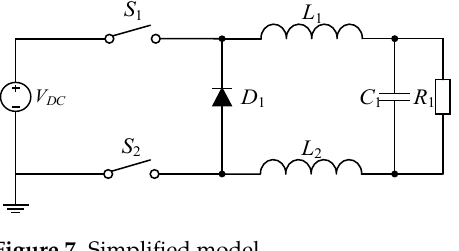
Figure 7. simpli fi ed model. Figure 7. Simplified